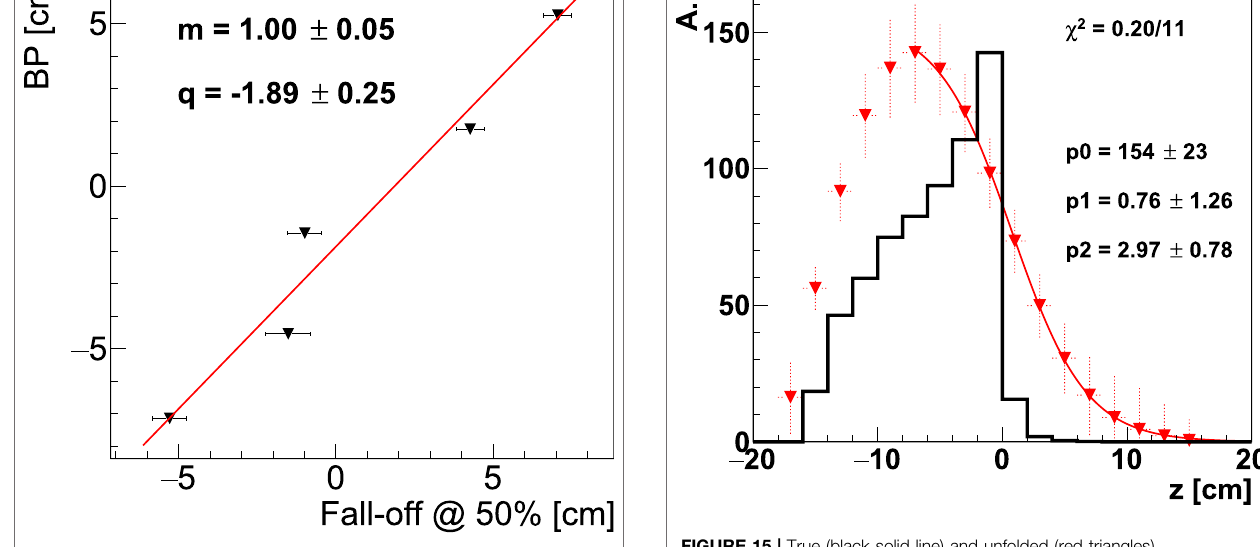
FIGURE 14 | Calibration curve of the theoretical Bragg peak positions for each simulated proton beam energy as a function of the fall-off at 50% of the unfolded distributions of the reconstructed prompt photon pro fi les. The point relatedtothe160 MeVprotonbeamhasbeenremovedfromthecalibration since it is used to assess the PAPRICA performances toward a realistic case.